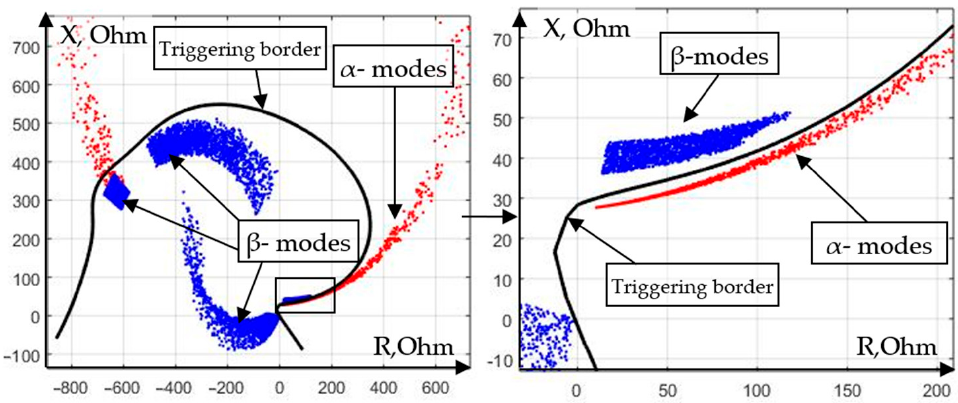
Figure 17. Separating border of the classifier “SVM T 1 ”.